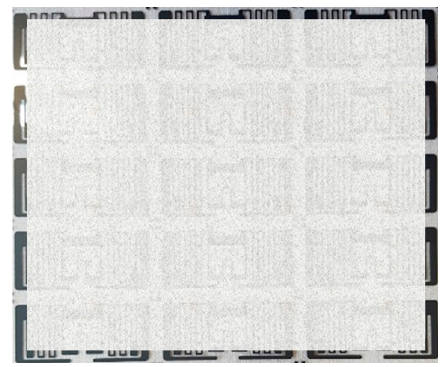
Figure 10. Photographic image of the specimens that were used for repetitive bending tests (A significant portion of the photograph is obscured to protect the confidentiality of the RFID Company’s antenna design).